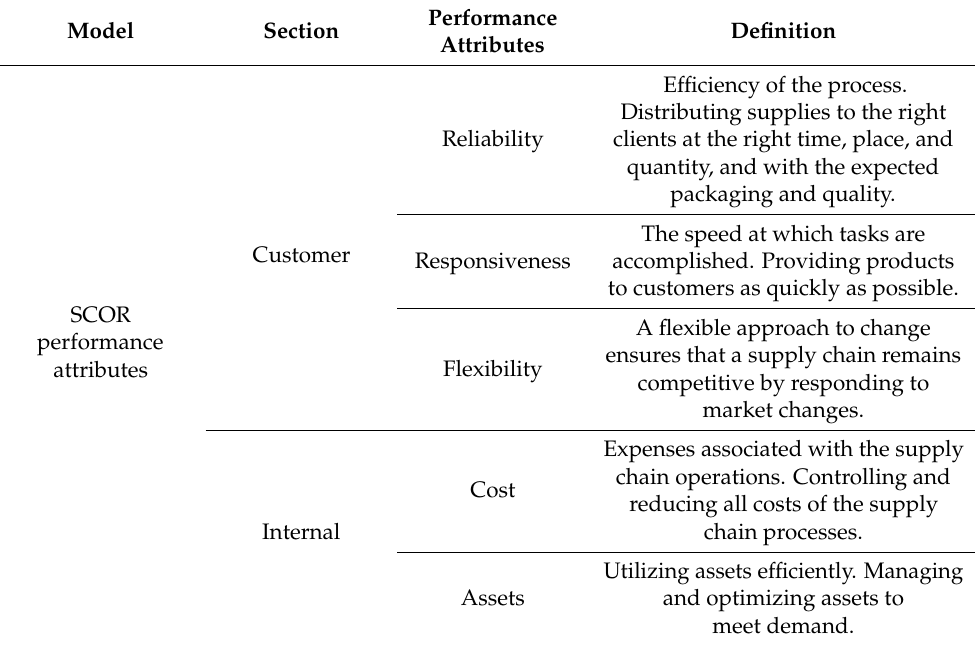
Table 1. SCOR performance attributes (main criteria) [37].